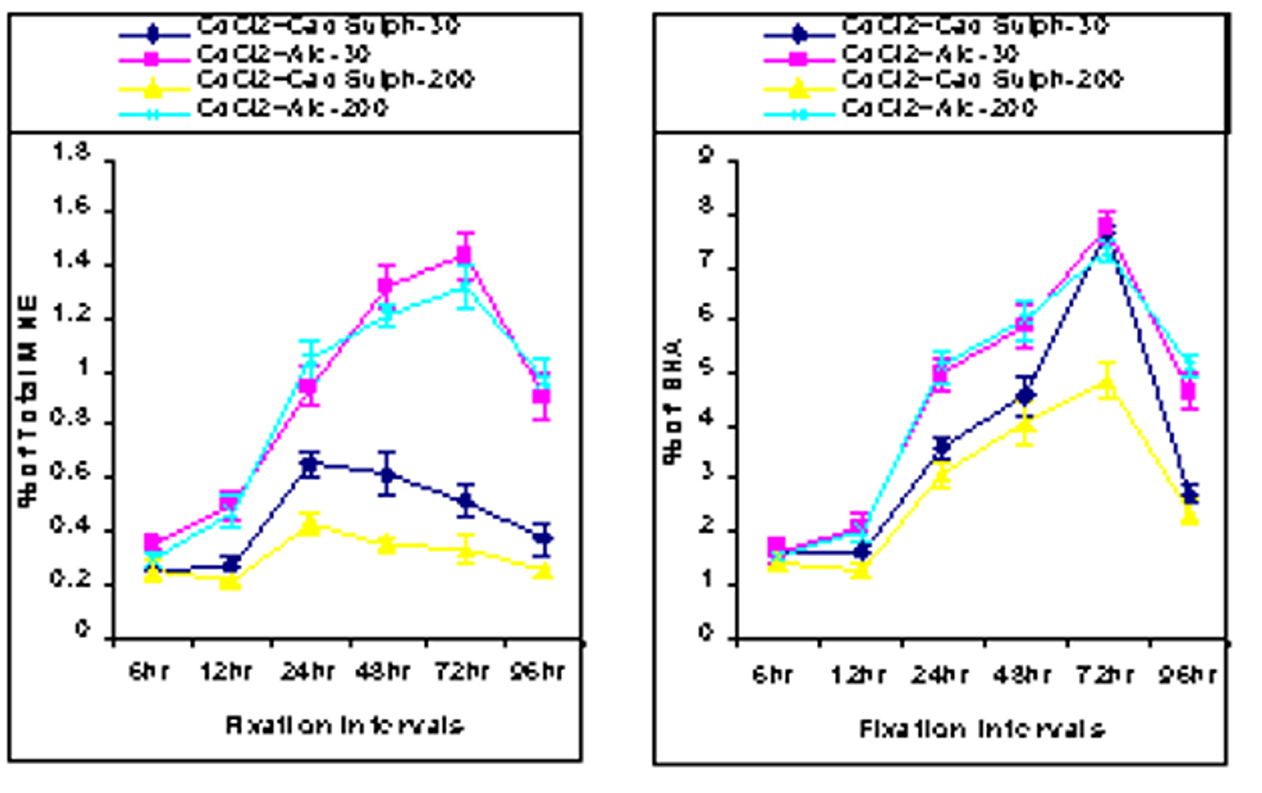
Figure 8 Showing time-dependent frequencies of Cad Sulph-30 post- fed and Cad Sulph-200 post-fed series versus their respective CdCl 2 treated alcohol-30 and alcohol-200 control mice. Chromosome aberration (CA)-5; Mitotic index (MI)-6; Micronucleated erythrocytes (MNE)-7 and Sperm head anomaly (SHA)-8.